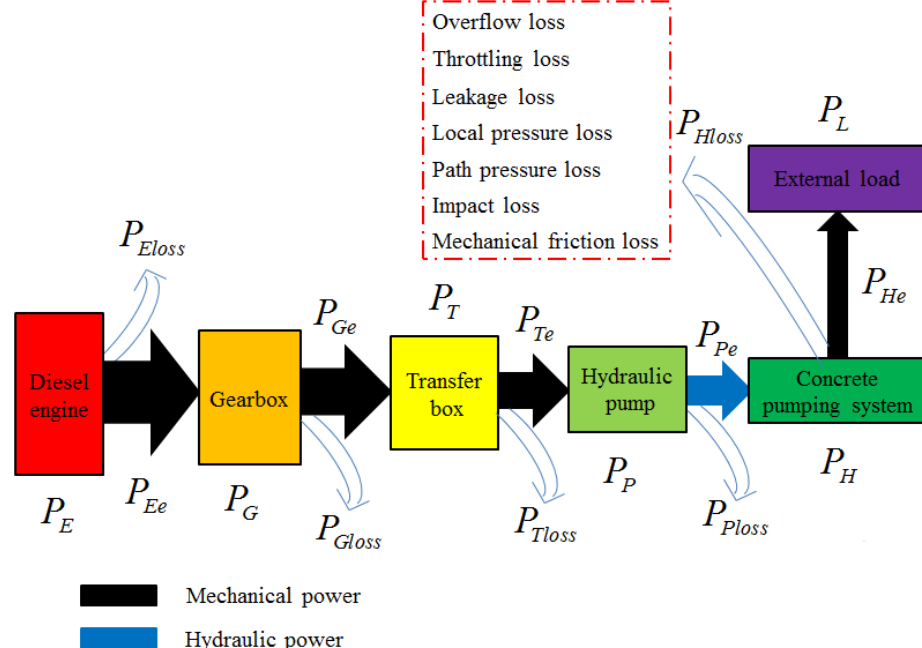
Figure 8. Energy flow route of transported/truck-mounted concrete pump.